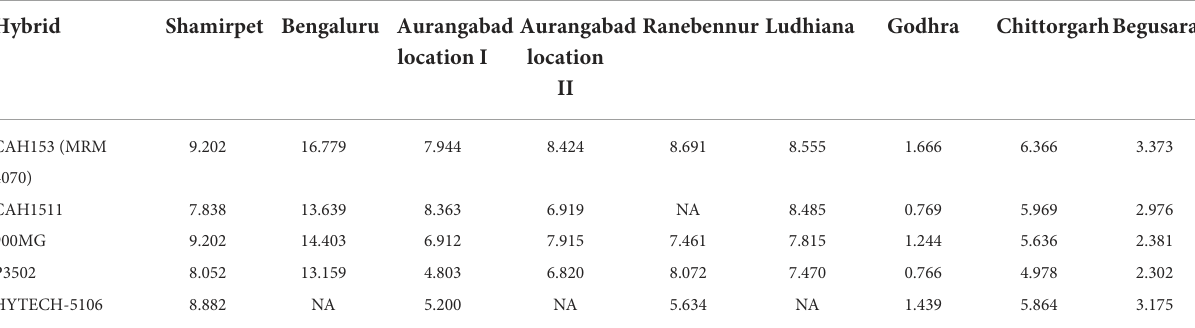
TABLE 3 Multi-location trial (MLT) of MRM4070 with other hybrids (checks) in Khaif 2017 (Yield: t/ha).